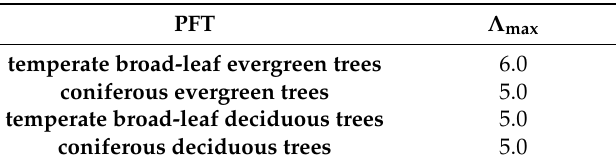
Table A2. The maximum LAI values in our